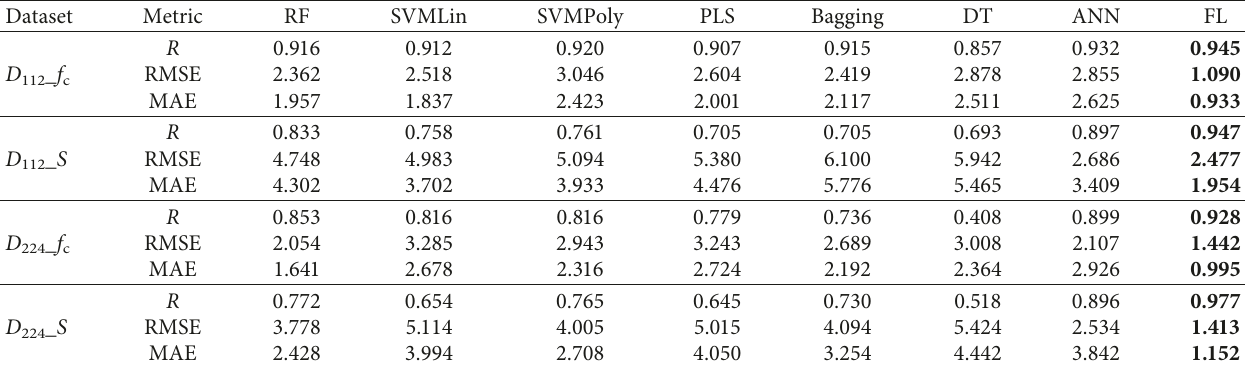
Table 6: Metrics results of the different regression